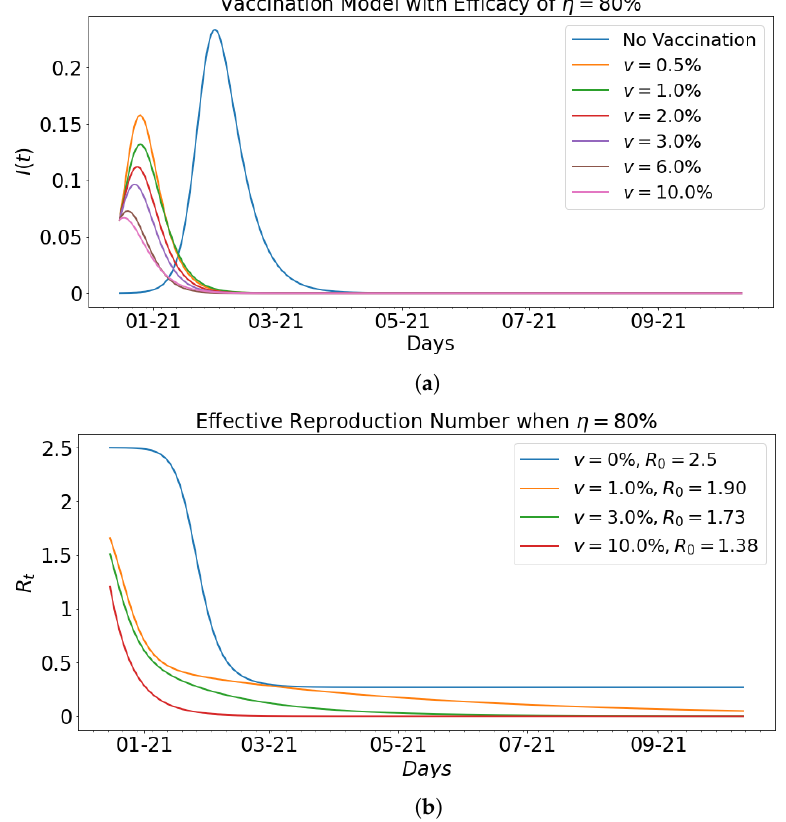
Figure 10. Vaccination model with effective reproduction number when efficacy is η = 80%; ( a ), it can be seen that as the vaccination rate v increases from 0% to 10%, the level of infectiousness decreases. The effective reproductive number is shown in ( b ) for different vaccination rates v with their respective basic reproduction number. As v = 0%, R 0 = 2.5 and vaccination rate increases from 0% to 3%, the R 0 decreases from R 0 = 2.5 to R 0 = 1.73. When the vaccination rate is increased further to 10%, it can be seen that the basic reproduction number reduces drastically to 1.38. This confirms the impact of vaccination in reducing the spread of the